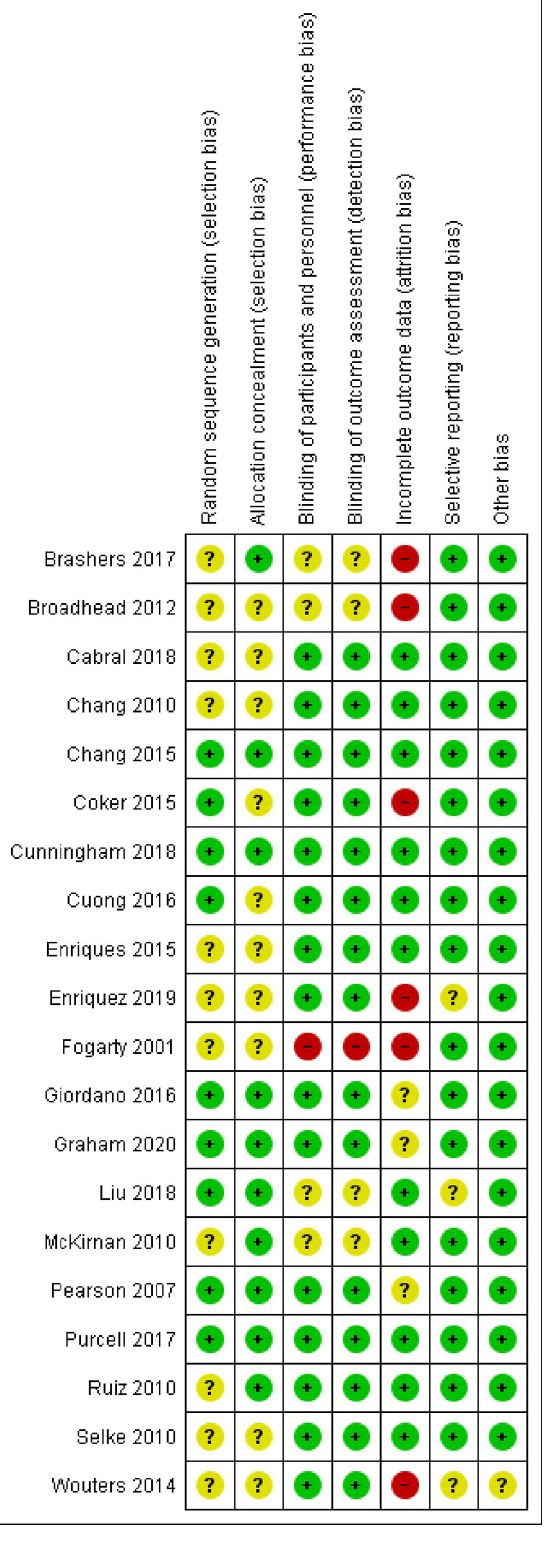
Fig 2. Risk of bias in included